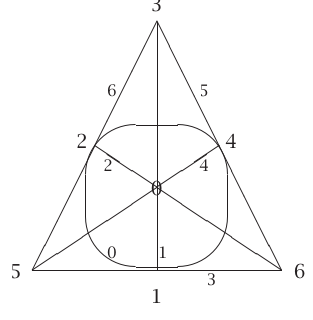
Figure 3.1 . Seven-point projective